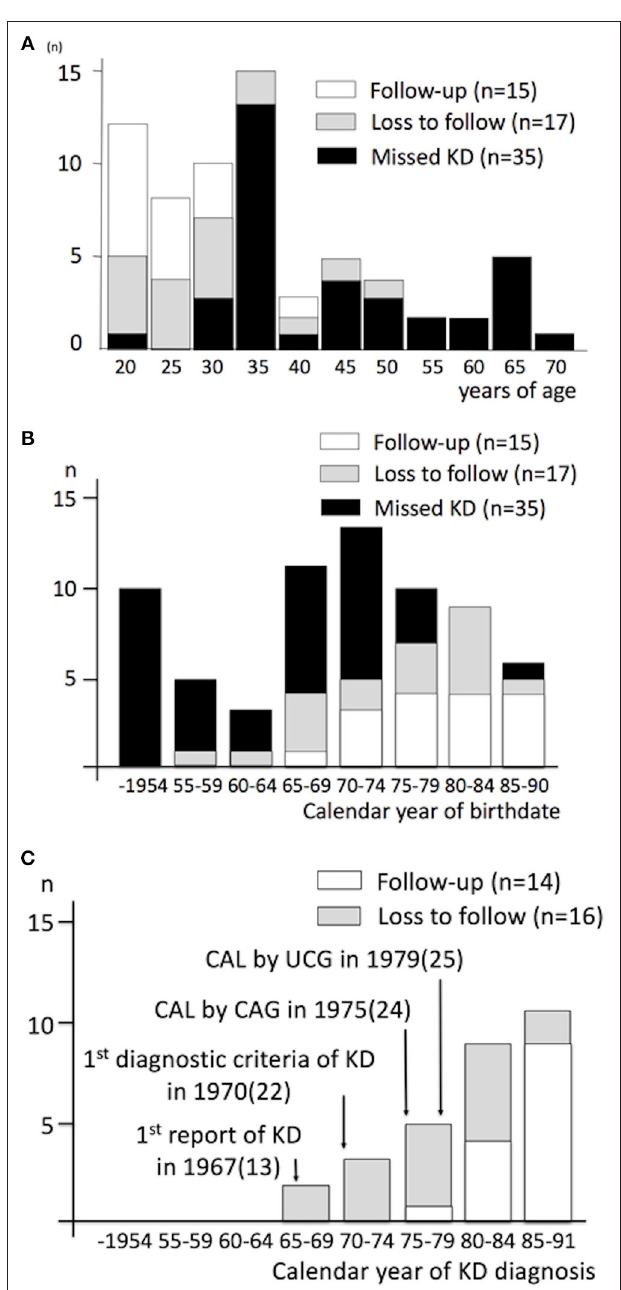
FIGURE 1 | Age at ACS and calendar year of birthdate and KD diagnosis, by the type of KD diagnosis and the follow-up status. (A) Age at acute coronary syndrome, (B) Calendar year of birthdate, (C) Calendar year of KD diagnosis. ACS denotes acute coronary syndrome; KD, Kawasaki disease; CAL, coronary artery lesion; CAG, coronary angiography; UCG, ultrasound cardiography; n, number of patients. Number in parenthesis indicates reference number.